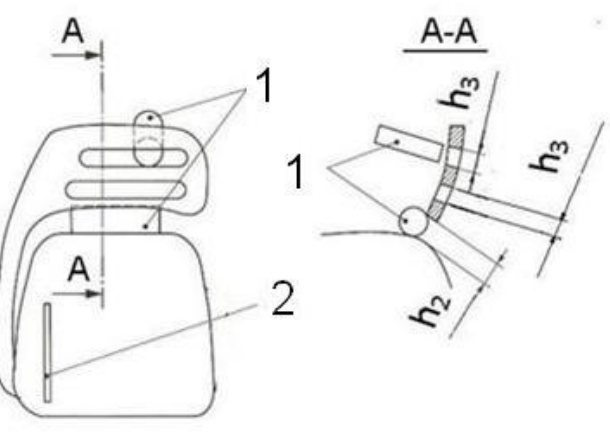
Figure 6. Checking permissible dimensions of front guard openings and permissible clearance between lowest front guard edge and closest part of chainsaw body. 1: test shaft Ø 56 × 82 mm; 2: guide